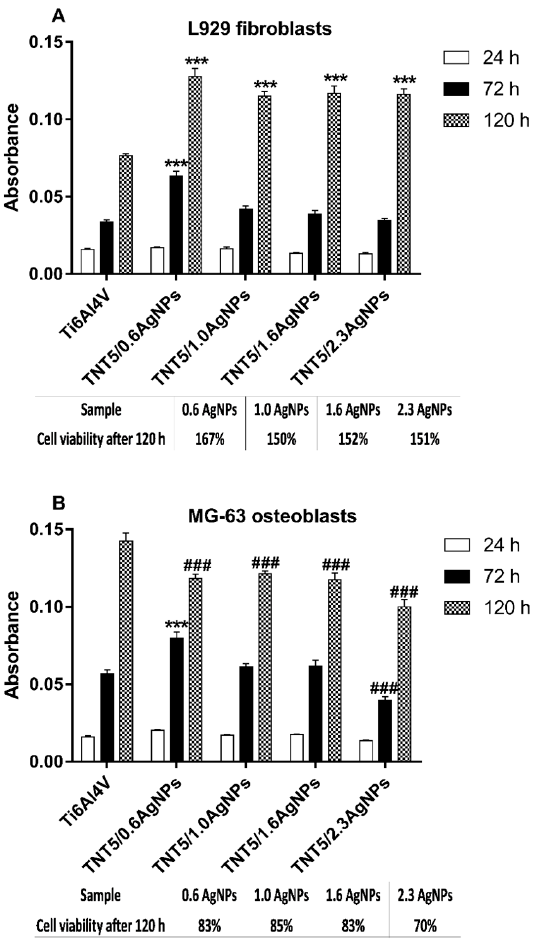
Figure 9. The effect of TNT5/AgNPs coatings on the L929 fibroblasts ( A ) and MG-63 osteoblasts ( B ) adhesion (measured after 24 h) and proliferation (evaluated after 72 h and 120 h), detected by the MTT assay. The absorbance values are expressed as means ± SEM of five independent experiments. Asterisks indicate significant differences at the appropriate incubation time when the level of cell proliferation on the surface of specimens coating doped by the different concentrations of Ag was higher compared to the reference Ti6Al4V alloy foils (Ti6Al4V) (*** p < 0.001). Hash marks denote significant differences at the appropriate incubation time when the level of cell proliferation on the samples enriched with AgNPs was lower in comparison with the reference Ti6Al4V alloy foils (### p < 0.001). Tables below Figure 9A,B presented relative L929 or MG-63 cells viability (%) compared to the Ti6Al4V reference sample measured after 120 h of incubation.